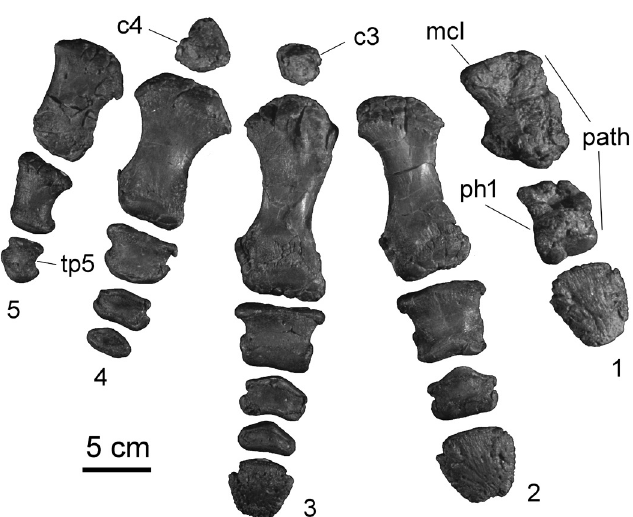
Figure 18. Right manus in dorsal view. Vagaceratops irvinensis , CMN 41357.